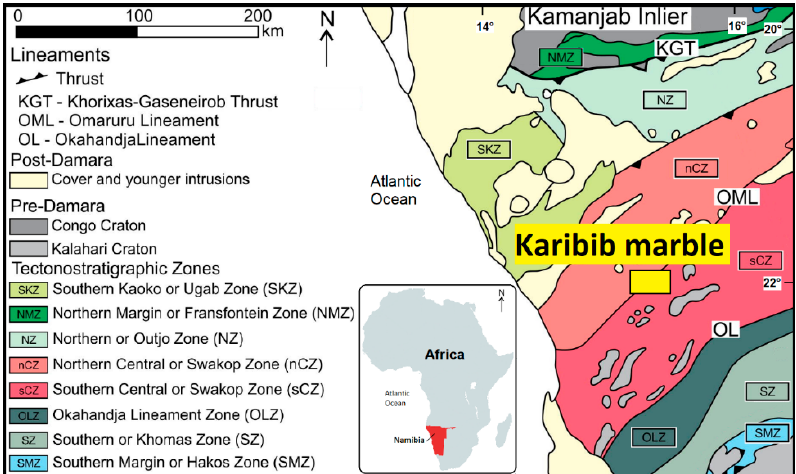
Fibers 2019 , 7 , x FOR PEER REVIEW Figure 1. Simplified tectonic map of the Damara Belt (Namibia (Africa). showing the distribution of the main tectono-stratigraphic zones according to [28]. Modified after [35]. In the Central Zone of the Damara Belt, the successions were deformed and metamorphosed to greenschist facies conditions reaching, in some sectors, metamorphic conditions of up to ca. 590 ◦ C and 0.5 GPa [39]. Moreover, a detailed structural mapping [40–45], highlighted as the most striking structural feature of the Central zone, is the northeast trending domes elongated at kilometer-scale [37,40,42,45,46], where the most important quarries are located (Figure 2).